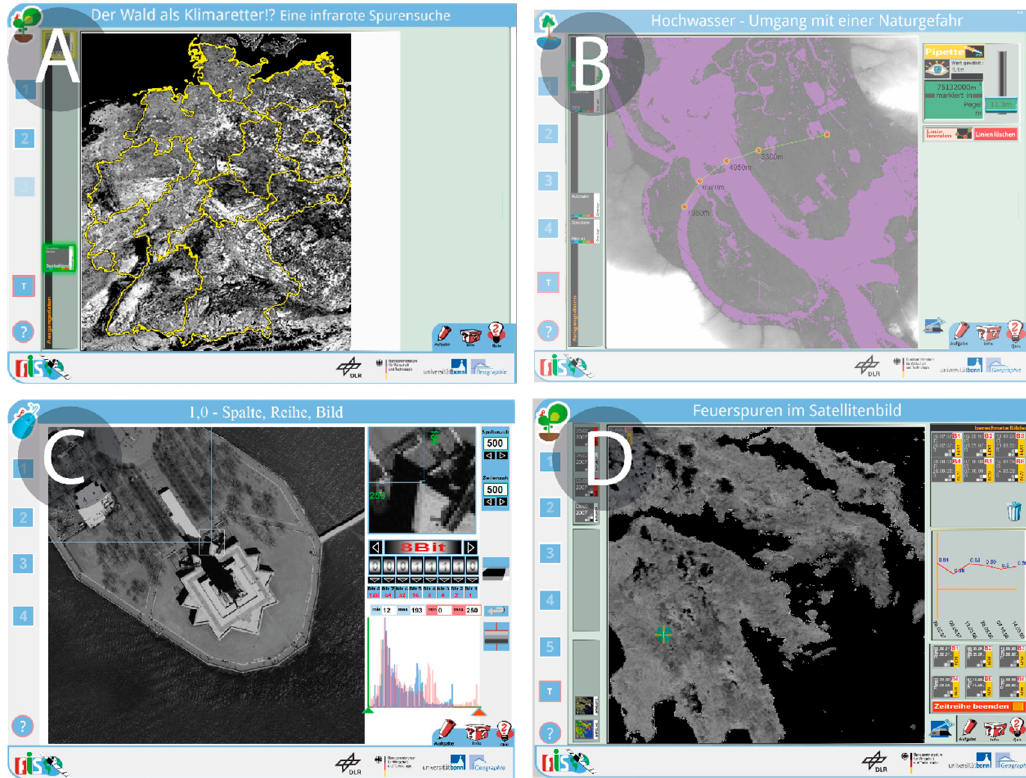
Figure 2. Different setups of available tools. ( A ) Minimal setup ( B ) Threshold classification; ( C ) Tools for bitwise pixel manipulation and histogram stretching; ( D ) NDVI Timeline Analysis (Source: see Appendix